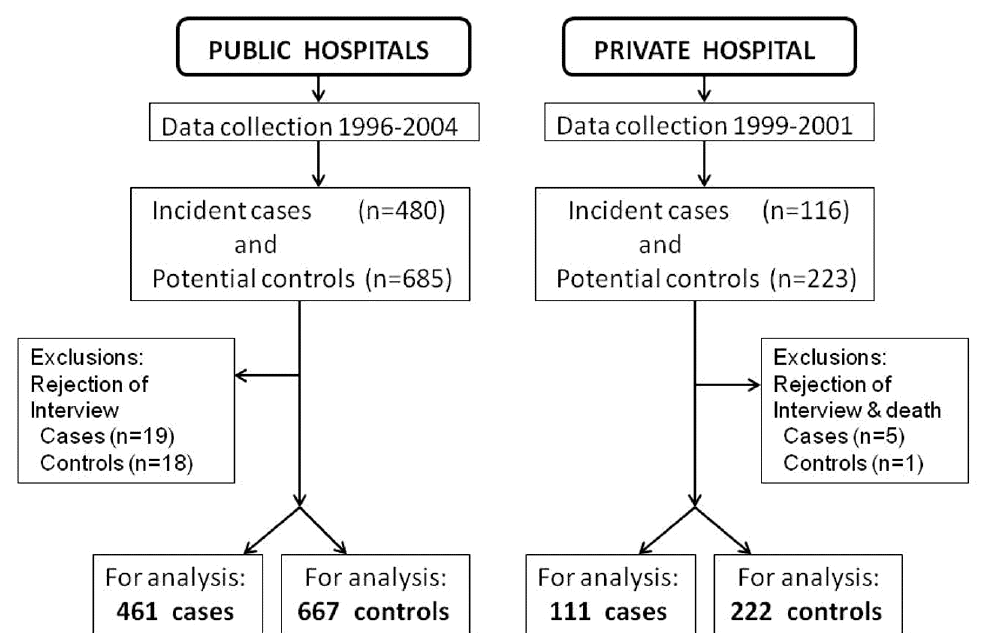
Figure 1. Flowchart summarizing each study’s